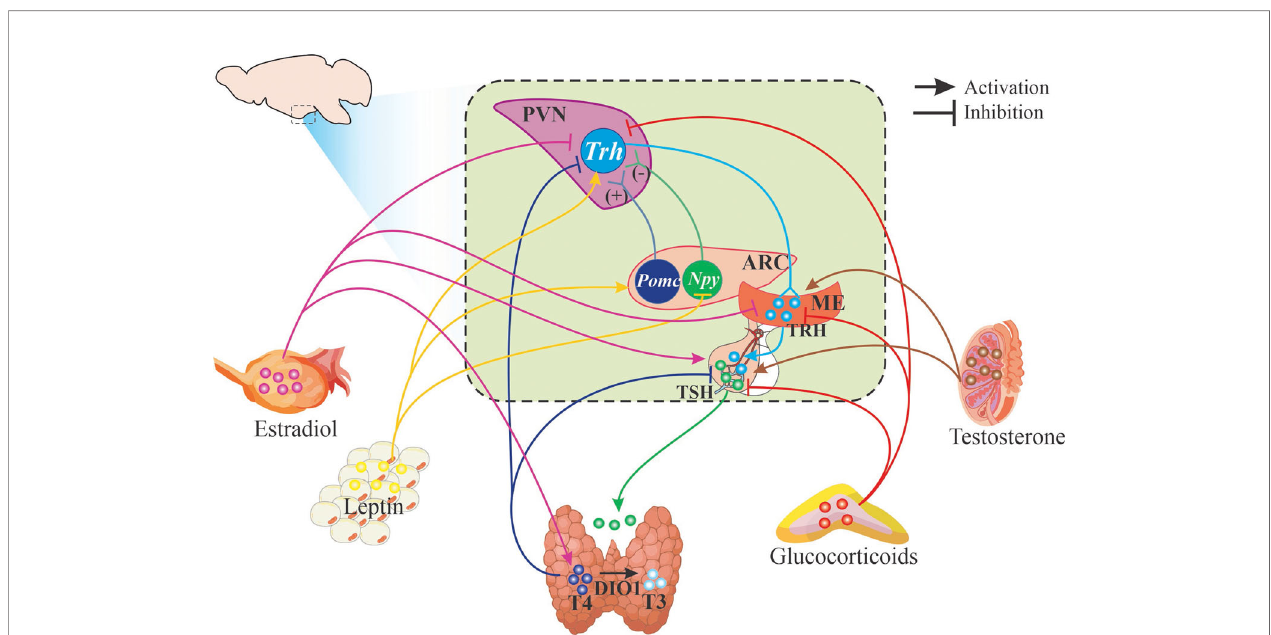
FIGURE 2 | Schematic representation of HPT axis regulation. Figure illustrates hypophysiotropic TRH neurons of the paraventricular nucleus of the hypothalamus (PVN) that send their axons (light blue line) to the median eminence (ME) where they release TRH. Only known effectors are signaled: neurons from the arcuate nucleus that synthesize POMC or NPY stimulate or inhibit Trh expression and release. Arrows (light blue and light green) depict the various steps of the HPT axis that are regulated by different hormones at the level of synthesis or release of TRH, TSH and thyroid hormones as well as their receptors (details in